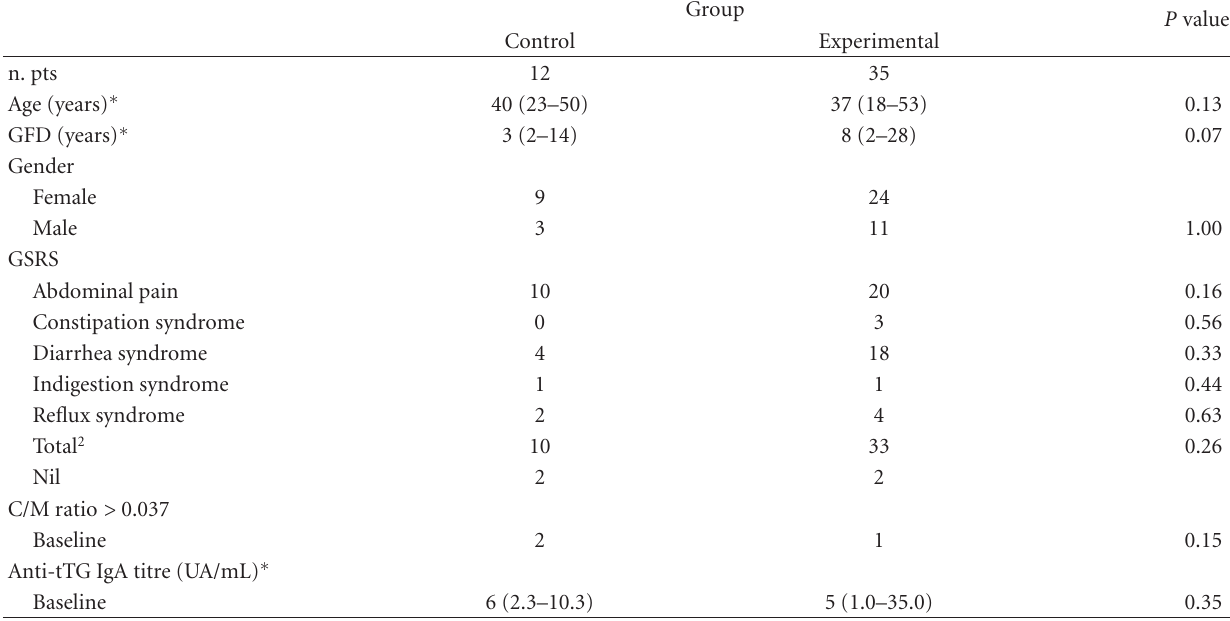
Table 1: Demographic data, clinical symptoms (GSRS) at diagnosis, and baseline laboratory investigations in 47 GFD CD